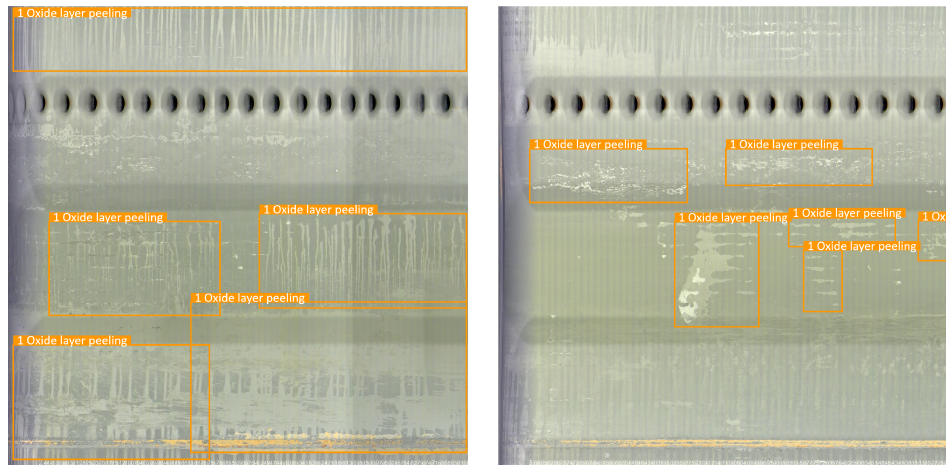
Figure 19. Detection result on the reforming collection pipeline